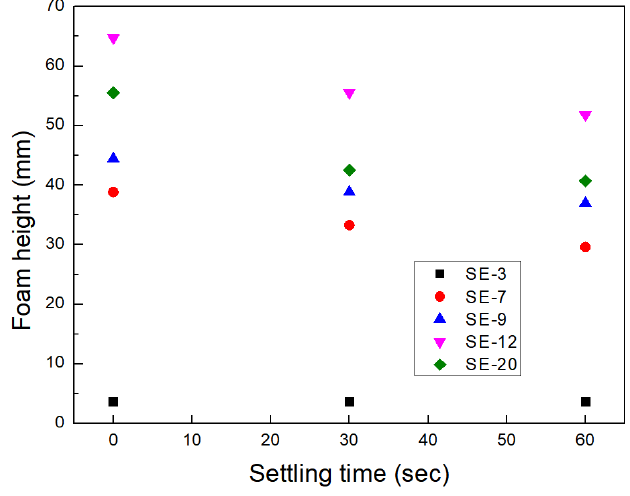
Figure 8. Foam height of the various degreasing solutions as a function of settling time.